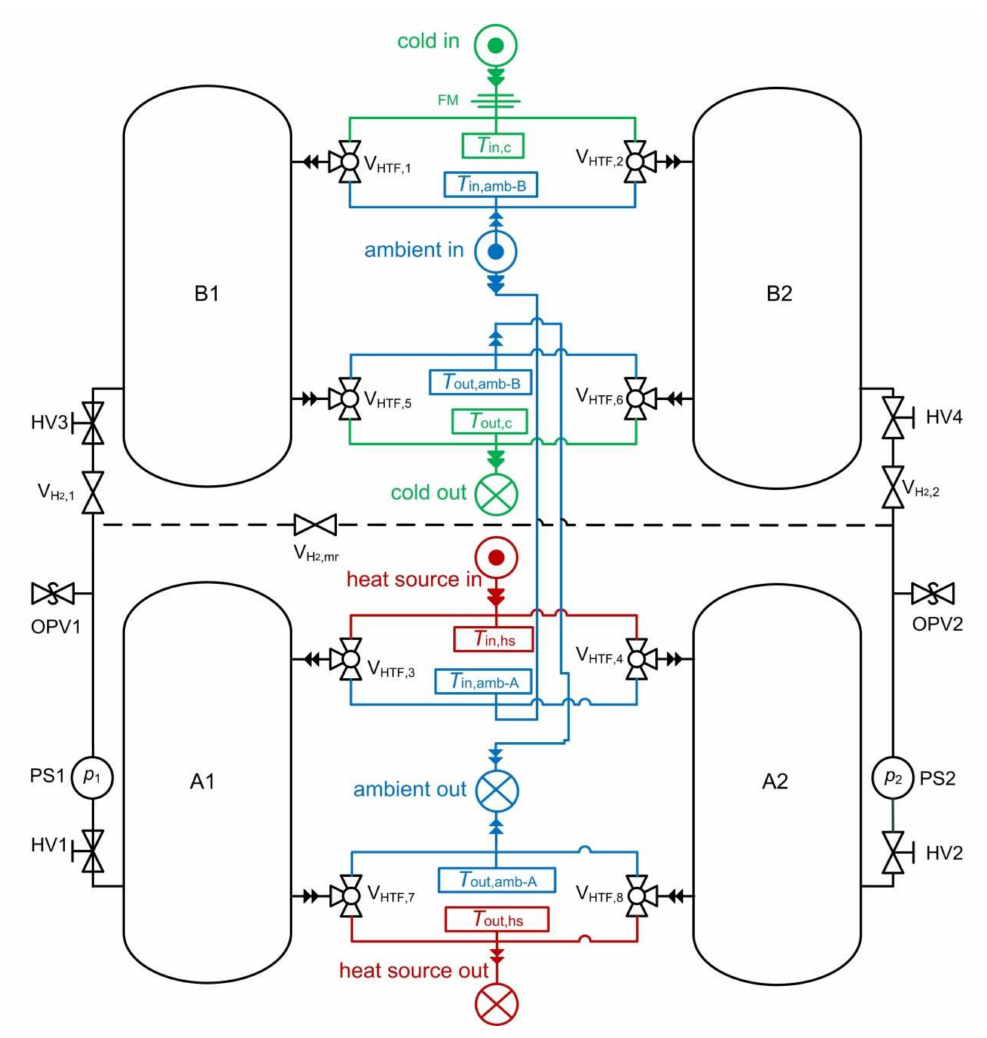
Figure 4. Schematic flow diagram of the realized modular